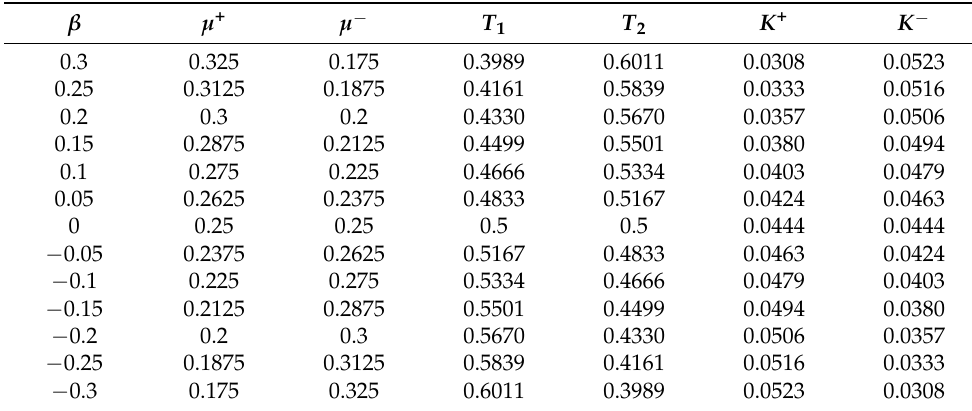
Table 1. Values of β and the corresponding computational